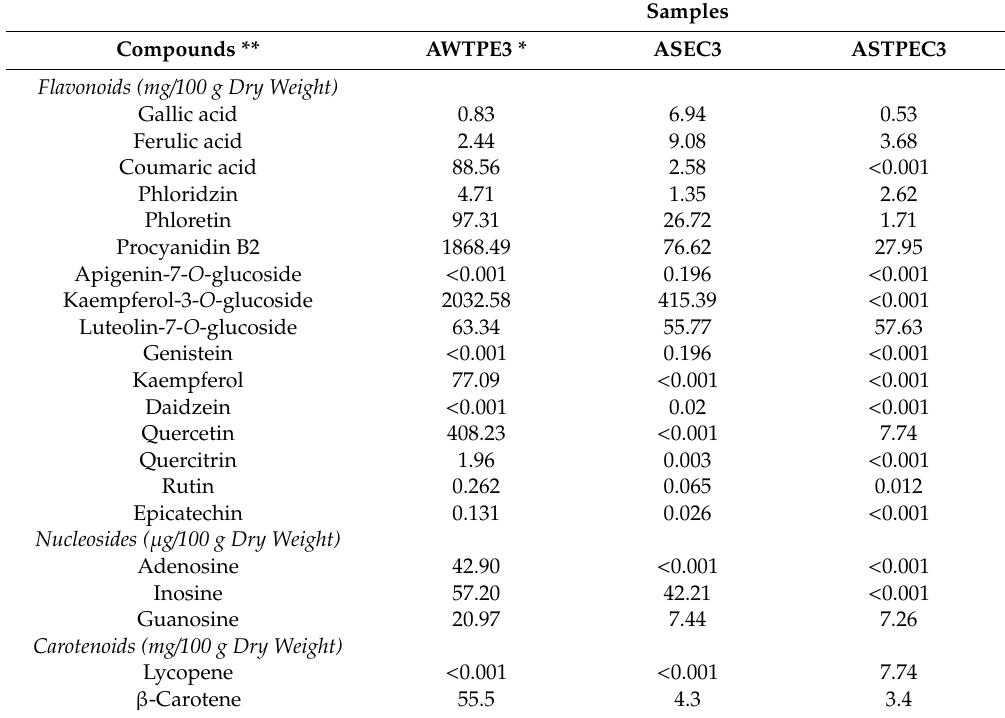
Table 2. Identification and quantification of bioactive compounds by